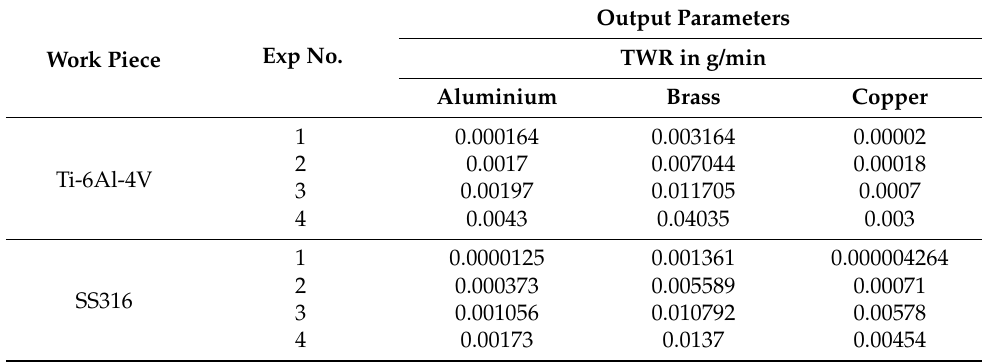
Table 7. The values of TWR for different tool–work piece combinations for different experiments.